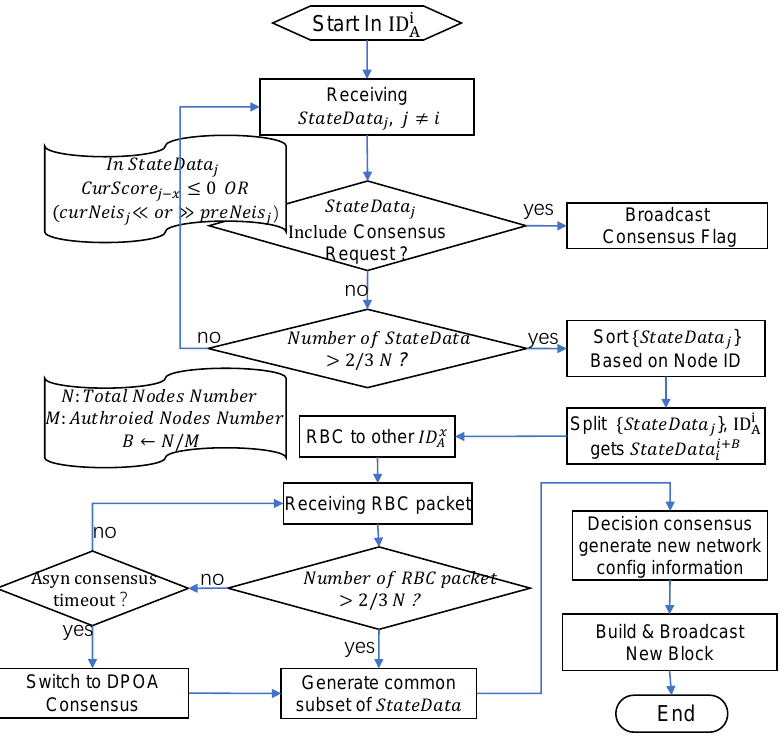
Figure 3. Two-stage consensus process in an authorized node ID i